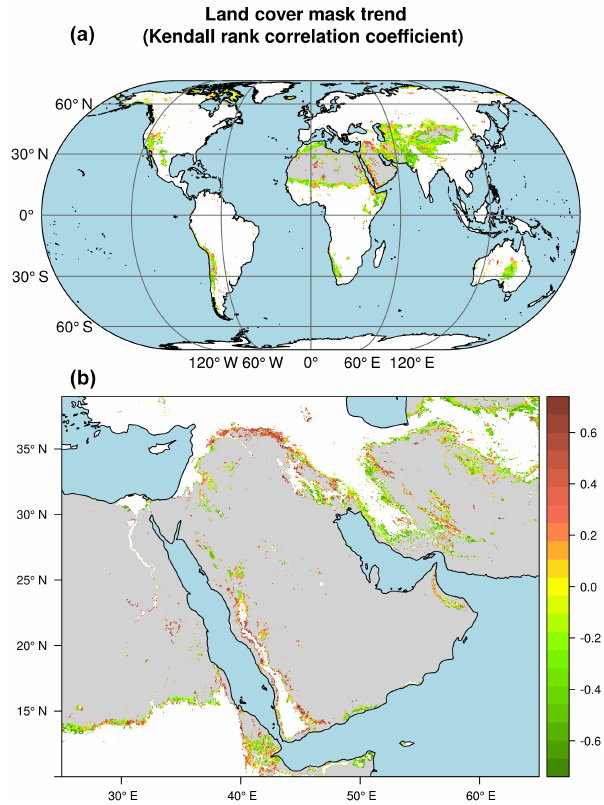
Figure 1. Trend of the dust emission mask based on the Moderate Resolution Imaging Spectroradiometer (MODIS) MCD12C1 land cover product during the period 2001 to 2012. Regions with chang- ing surface properties are coloured according to the Kendall rank correlation coefficient τ of time and mask value, depicting expan- sion of source regions (i.e. positive correlation coefficients) in red and contraction in green. Regions where the land cover remained unchanged are grey (source regions) or white (non-source regions). For better readability, in the global plot (a) the values have been av- eraged over 10 × 10 pixels ignoring constant pixels. The magnified plot of the Middle East (b) shows the original 0 . 05 ◦